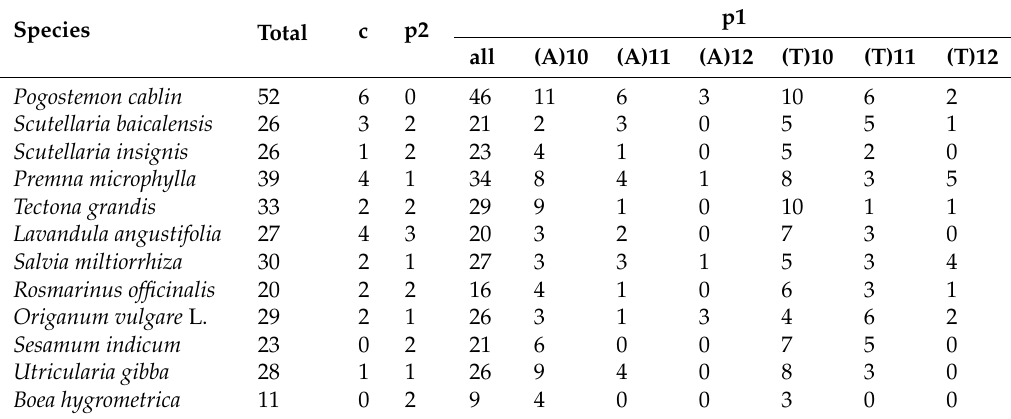
Table 3. Statistics of chloroplast SSRs (simple sequence repeats) detected in 12 species in Lamiales . Species